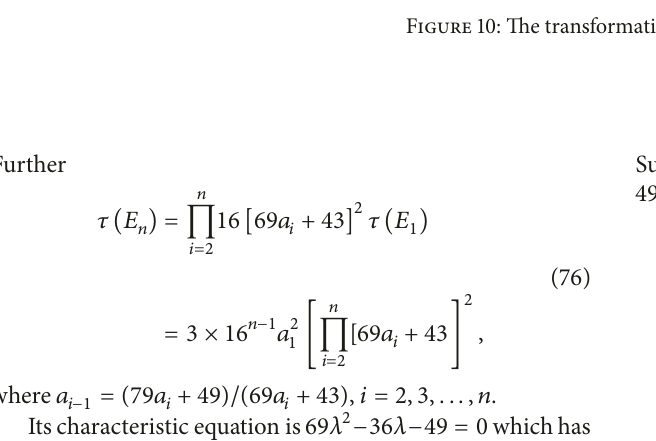
Figure 10: The transformations from 𝐸 2 to 𝐸 1